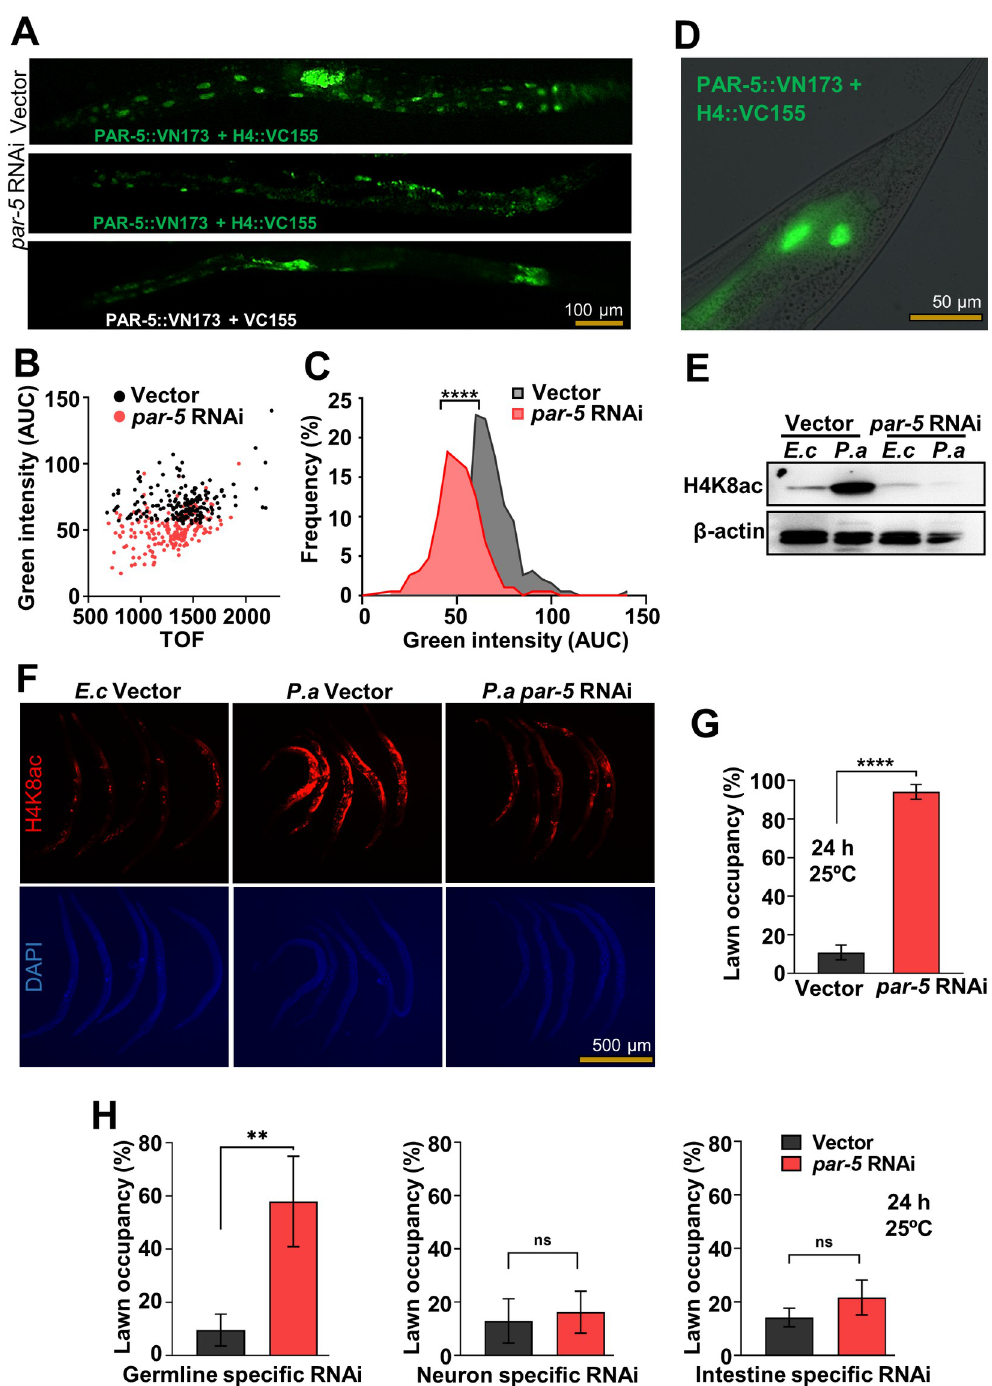
Fig 3. PAR-5 is required for P . aeruginosa H4K8ac in the germline. (A) Representative microscopic images of vector control or par-5 RNAi animals expressing BiFC constructs 12 hours after heat shock at 33˚C. Control animals without the H4 ::VC155 construct were used to establish the background fluorescence. (B) Dot-plot representation of green fluorescence intensity versus TOF of vector or par-5 RNAi BiFC animals. (C) Frequency distribution of green fluorescence-AUC of vector and par-5 RNAi transgenic BiFC animals. Three independent experiments were performed. “ � ” indicates significant difference; ���� P � 0.0001. (D) High-magnification fluorescent micrograph of nuclear localization of PAR-5 protein,